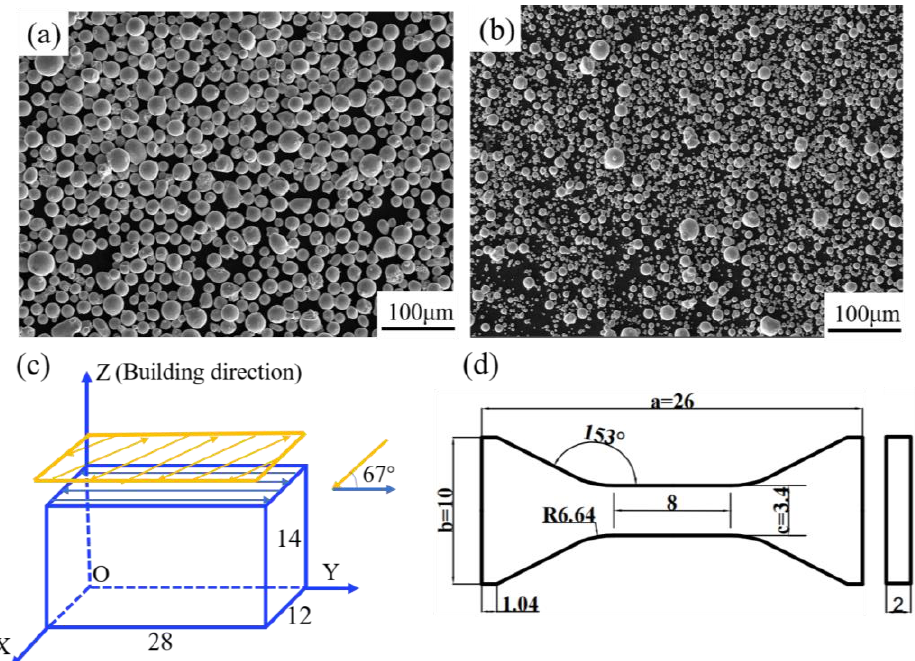
Figure 1. Secondary electron (SE) images of the powder morphology for ( a ) 13Co and ( b ) 35Co; the schematic images illustrate ( c ) the laser-scanning strategy and the size of a stretched specimen; ( d ) the geometry of the tensile specimen with a thickness of 2 mm. Table 1. Nominal compositions of the two alloys (wt.%).